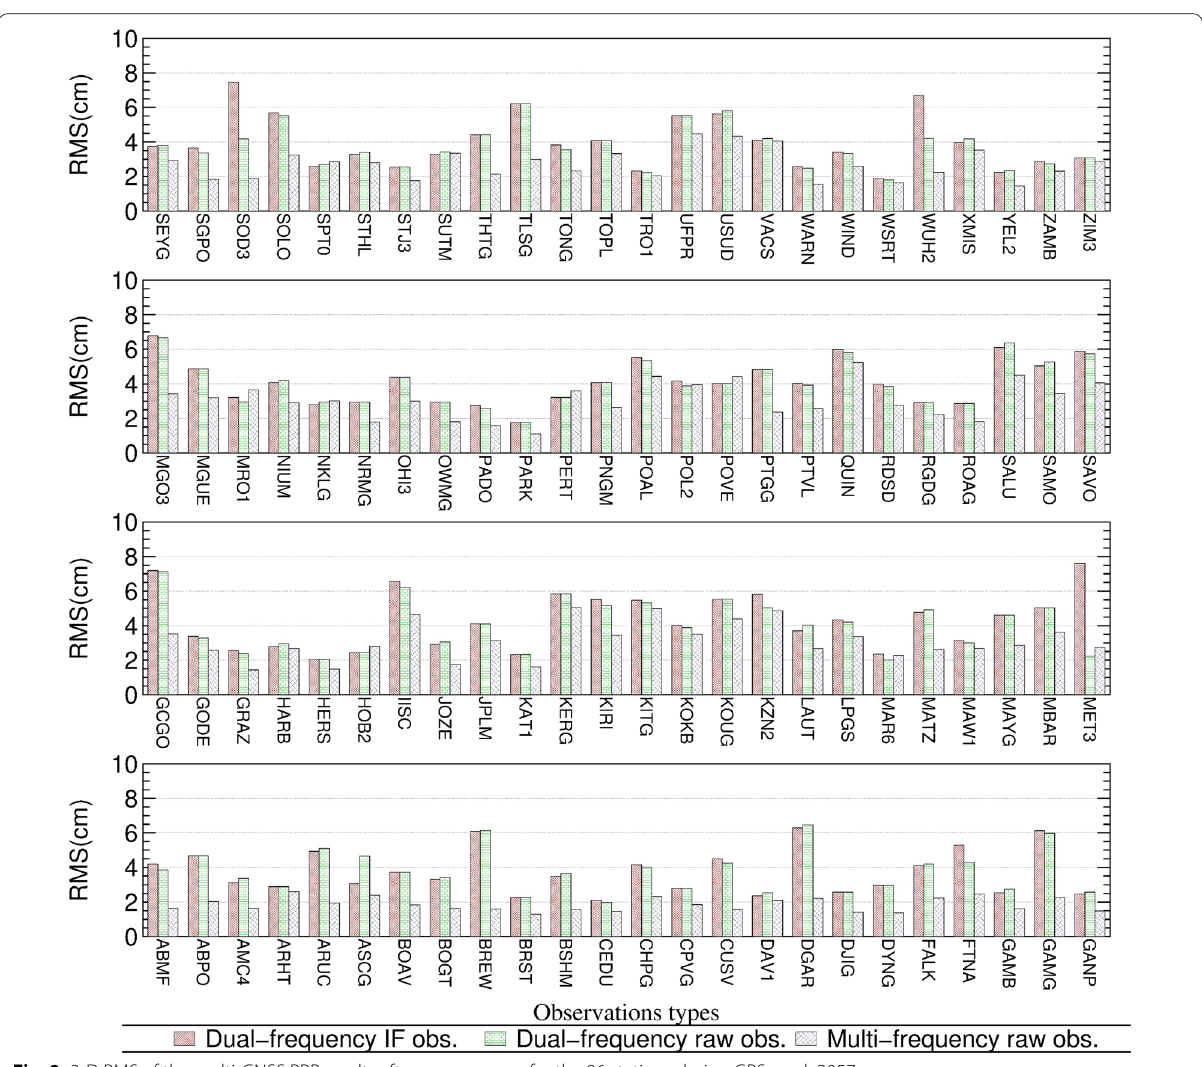
Fig. 9 3-D RMS of the multi-GNSS PPP results after convergence for the 96 stations during GPS week 2057